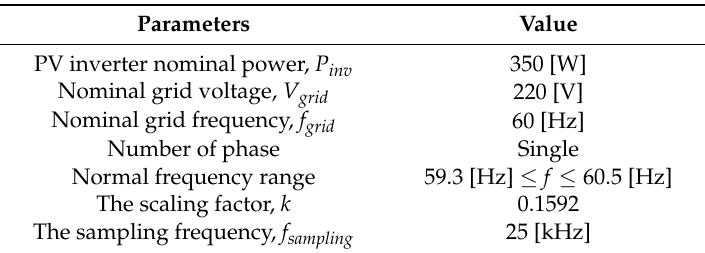
Table 1. Electrical specification of the simulation circuit.